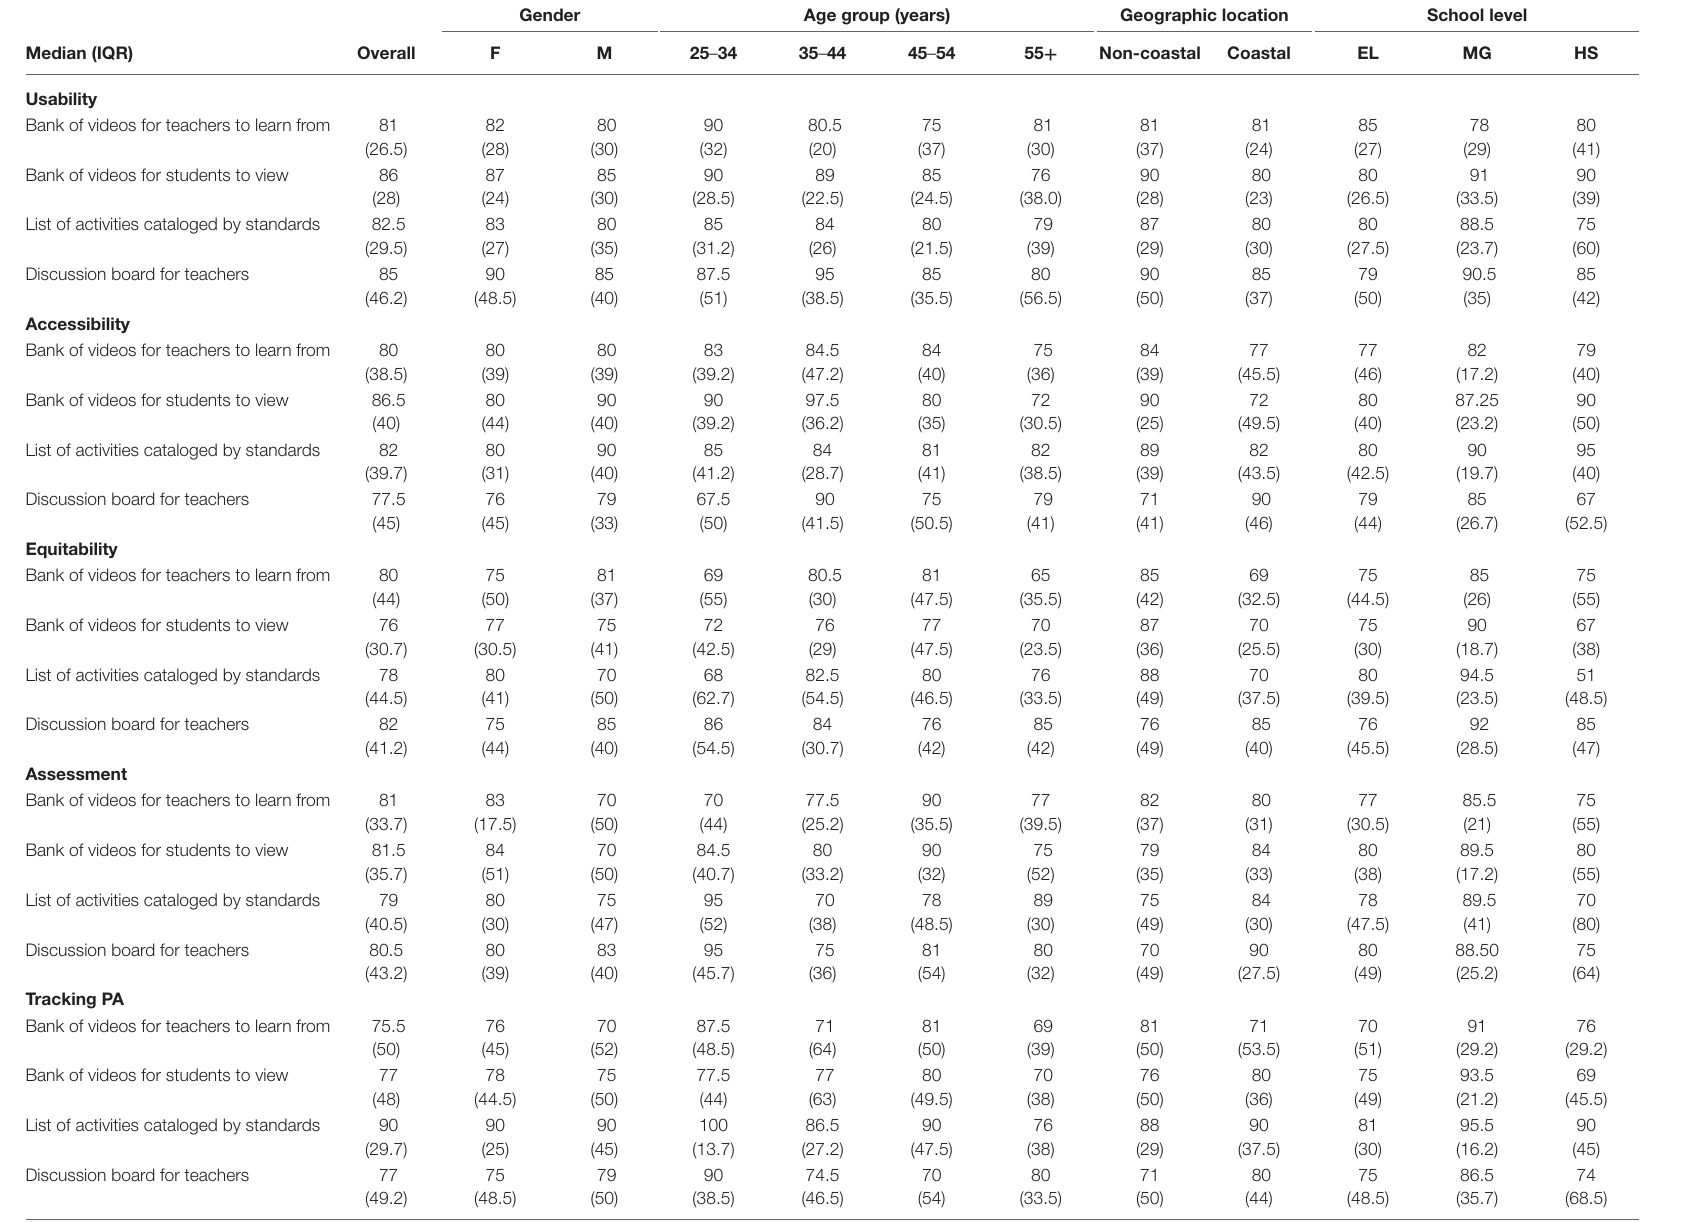
TABLE 2 | Median with interquartile range scores of each design feature by key attribute. Gender Age group (years) Geographic